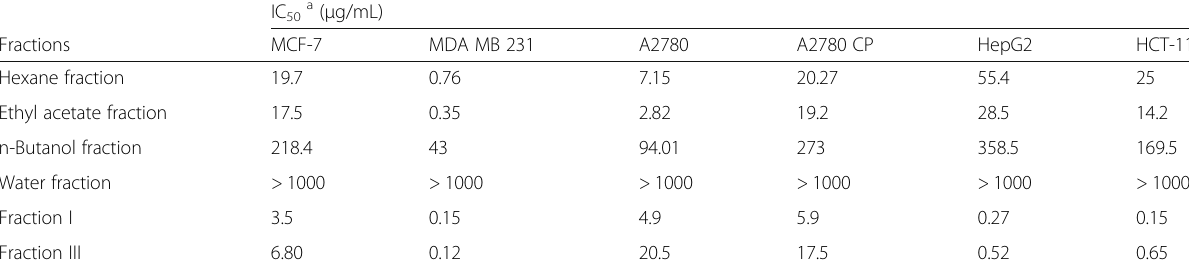
Table 4 Cytotoxic effects of the tested fractions